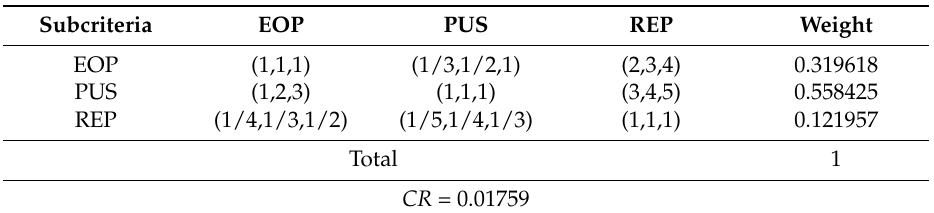
Table A7. Comparison matrix for SOF based on subcriteria.